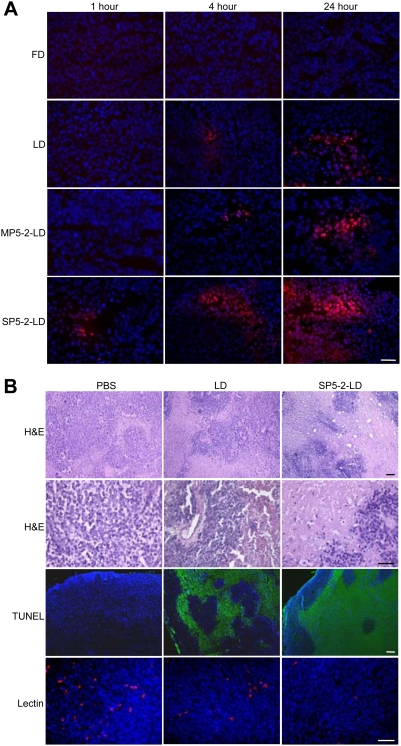
SP5-2 enhanced drug delivery to tumor tissues and increased therapeutic efficacy.(A) Representative two-color images showing the distribution of doxorubicin (red) in relation to nuclei (blue) in tissue sections. Accumulation of doxorubicin in tumor tissues was shown at 1, 4 and 24 hours post-injection. Bar, 50 µm. (B) Histopathology and fluorescent staining of tumor tissues in each treatment group examined after staining with H&E, TUNEL (green), lectin (red), and DAPI (blue). Bar, 50 µm. Enhancement of drug accumulation in tumor tissues correlated with the increased therapeutic efficacy.